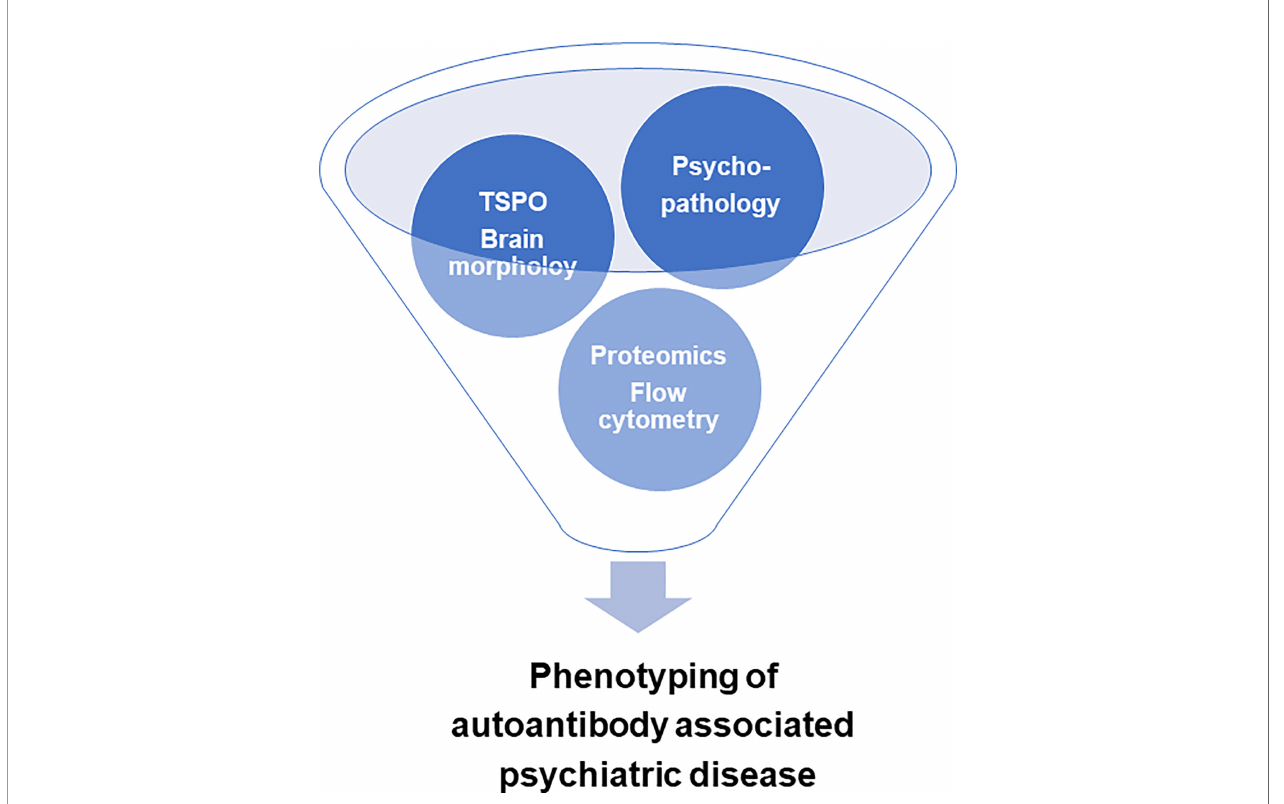
FIGURE 1 | Innovative technology for optimizing the characterization of autoantibody-associated psychiatric disease. TSPO = activated microglia translocator protein 18kDa through positron emission tomography